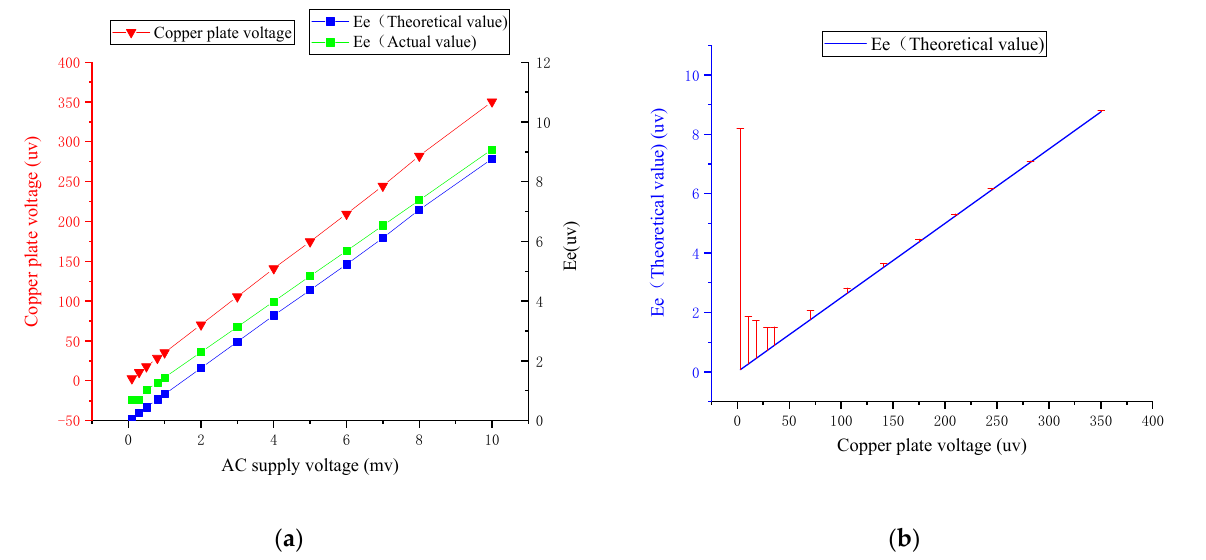
Figure 9. Analysis of AC electric field test results: ( a ) trend between copper voltage input and XCP induced different voltage Ee; ( b ) error analysis of different XCP induction voltage Ee under copper plate voltage.